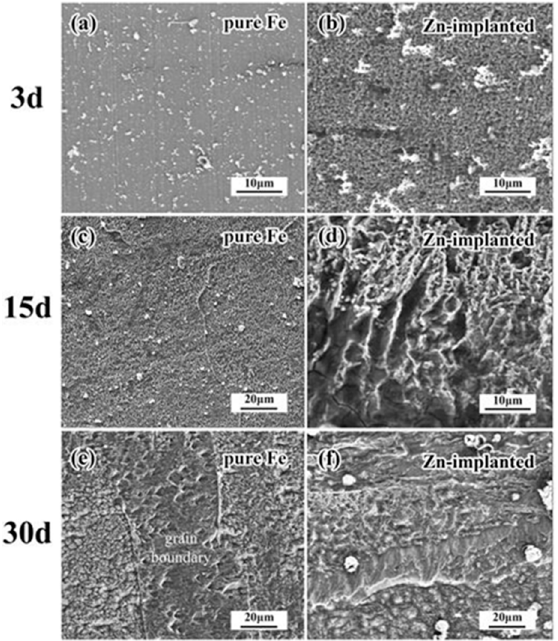
Figure 10. SEM images showing the corrosion after 3, 15 and 30 days. The image shows the increased corrosion rate of the Zn- implanted iron ( b , d,f ) in comparison to the pure iron ( a , c,e ) samples, with pure Fe samples degrading mostly along the grain boundaries ( e ). Reproduced with permission from